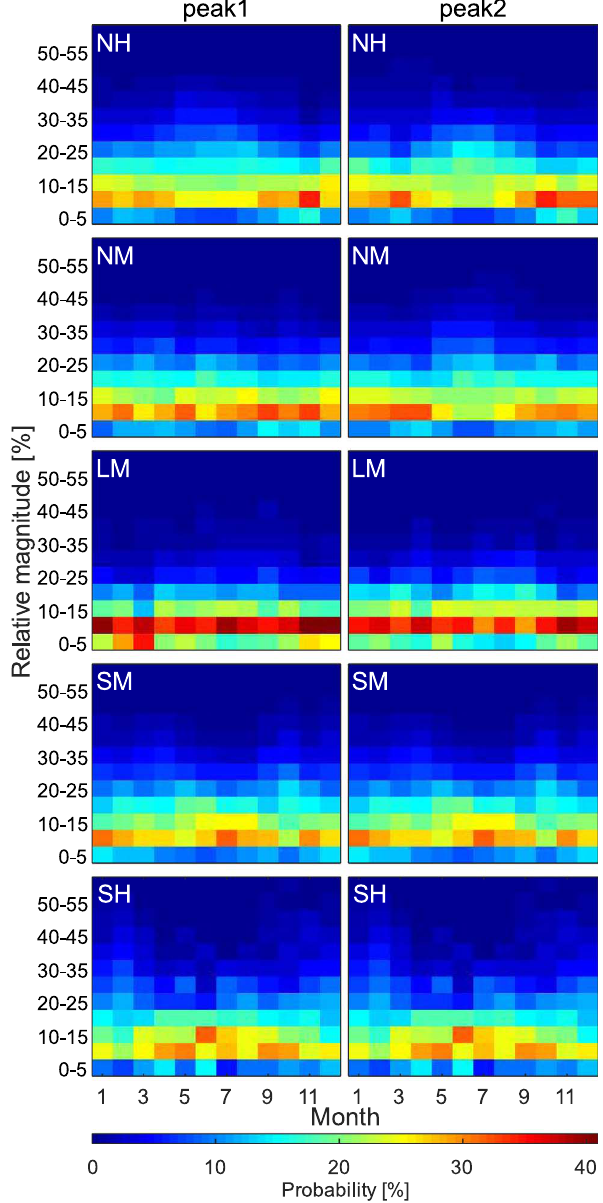
Figure 13. The probability distribution of the relative magnitude of the two peaks in different MLAT regions in each